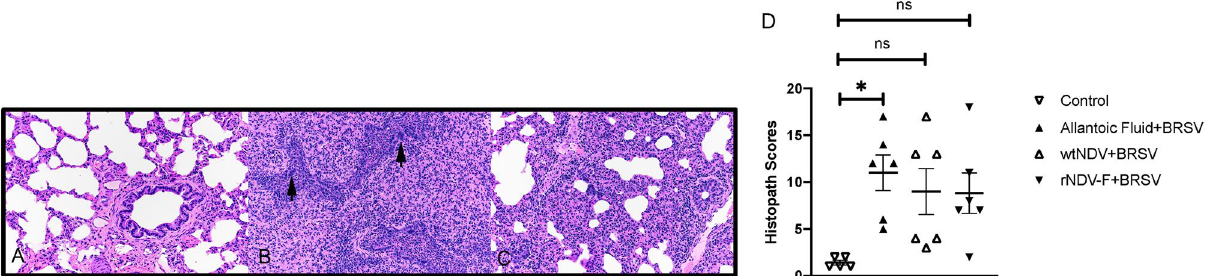
Figure 3. Reduced microscopic pathology in lungs of rNDV-BRSV F opt vaccinated colostrum-deprived calves. Representative image of lung of non-vaccinated, non-infected calf ( A ). Significant microscopic lesions are shown in a representative photomicrograph from a non-vaccinated BRSV challenged calf ( B ). Alveolar septa are thickened due to congestion and infiltrates of macrophages, lymphocytes and neutrophils. Bronchioles are lined by attenuated epithelium with multifocal regions of epithelial cell loss. Bronchiolar lumens are variably filled with neutrophils, sloughed epithelial cells, debris and low numbers of multinucleated syncytial cells. Lesions in calves vaccinated with rNDV-BRSV F opt ( C ) were primarily those involving alveolar septa (congestion, cellular infiltrates) with less involvement of bronchioles compared to non-vaccinated calves. In ( D ), histological scores are shown for each individual animal in each treatment group. Statistical analyses were performed using ANOVA. * p < .05, ** p < .01.